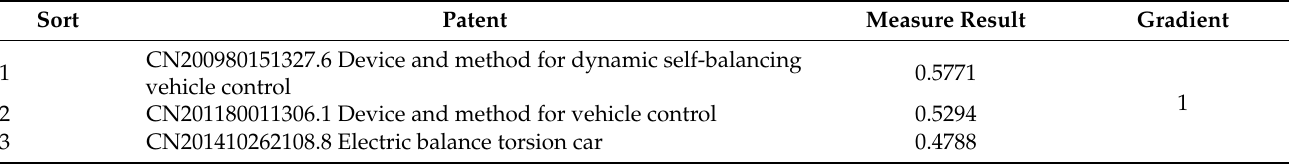
Table 16. Ranking table of the patent value scores of self-balancing